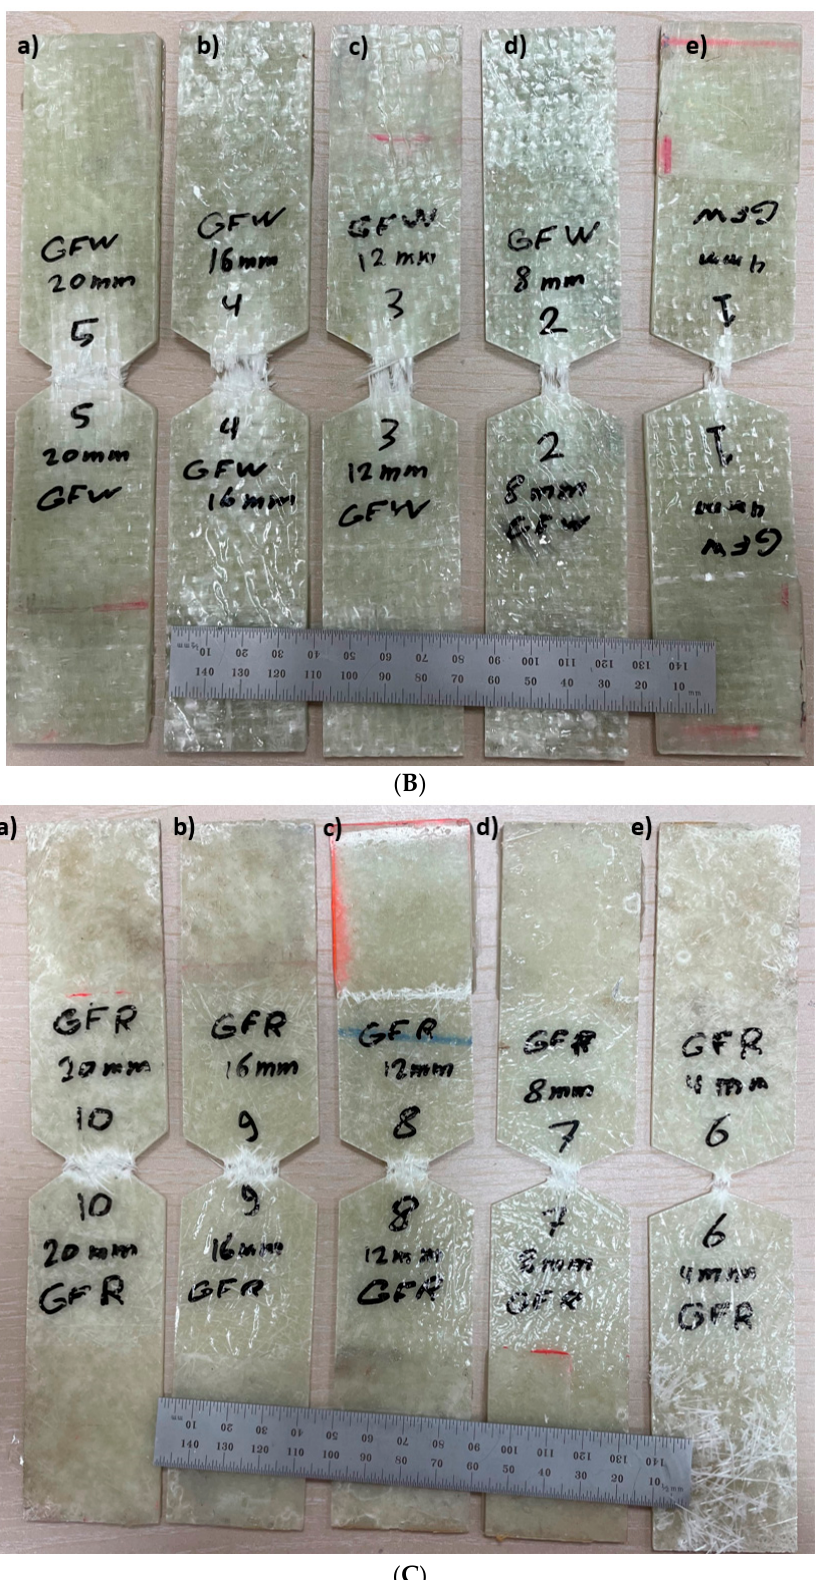
Figure 14. ( A ) Failure modes in EWF test of CFRP: ( a ) 20 mm, ( b ) 16 mm, ( c ) 12 mm, ( d ) 8 mm and ( e ) 4 mm. ( B ) Failure modes in EWF test of GFRP-W: ( a ) 20 mm, ( b ) 16 mm, ( c ) 12 mm, ( d ) 8 mm and ( e ) 4 mm. ( C ) Failure modes in EWF test of GFRP-R: ( a ) 20 mm, ( b ) 16 mm, ( c ) 12 mm, ( d ) 8 mm and ( e ) 4 mm.